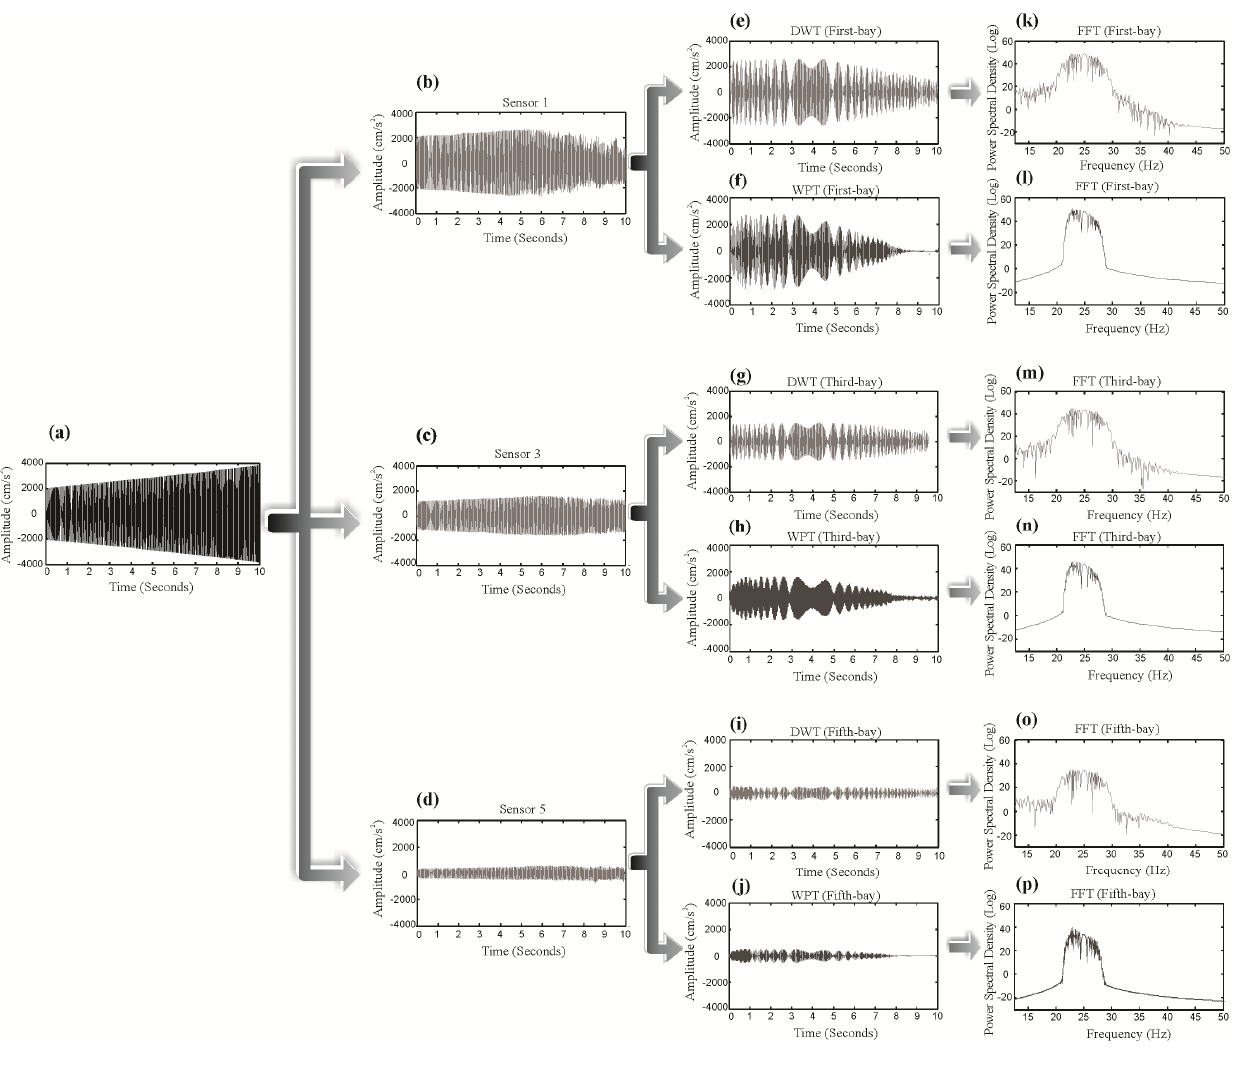
Figure 11. Synthetic signal. 2 Fig. 11. Synthetic signal.